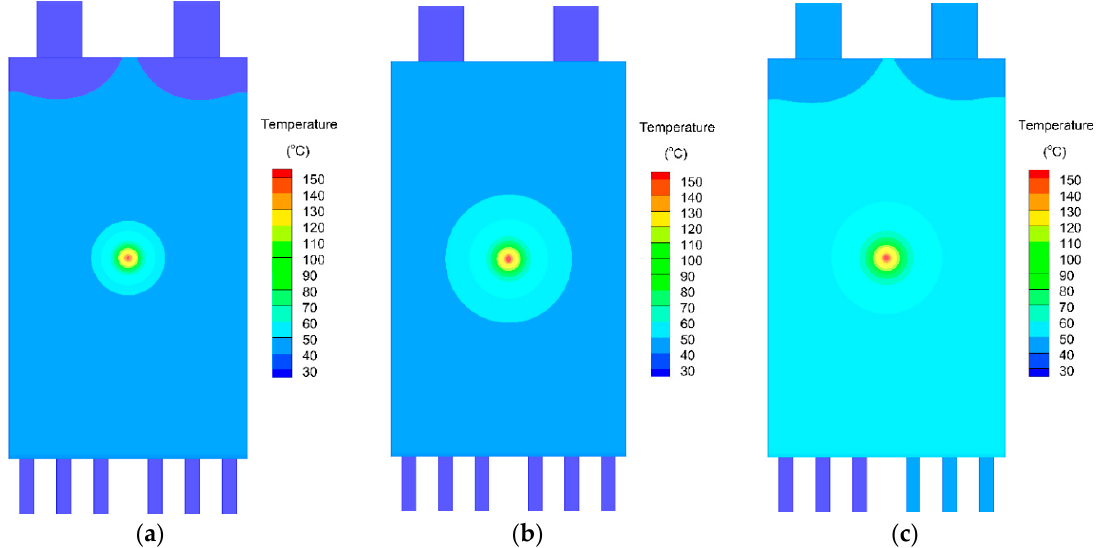
Figure 12. Temperature distributions of lithium-ion battery cooled by mini-channel cold plate with coolant velocity of 0.05 m/s at ( a ) 15 s; ( b ) 30 s; ( c ) 60 s.